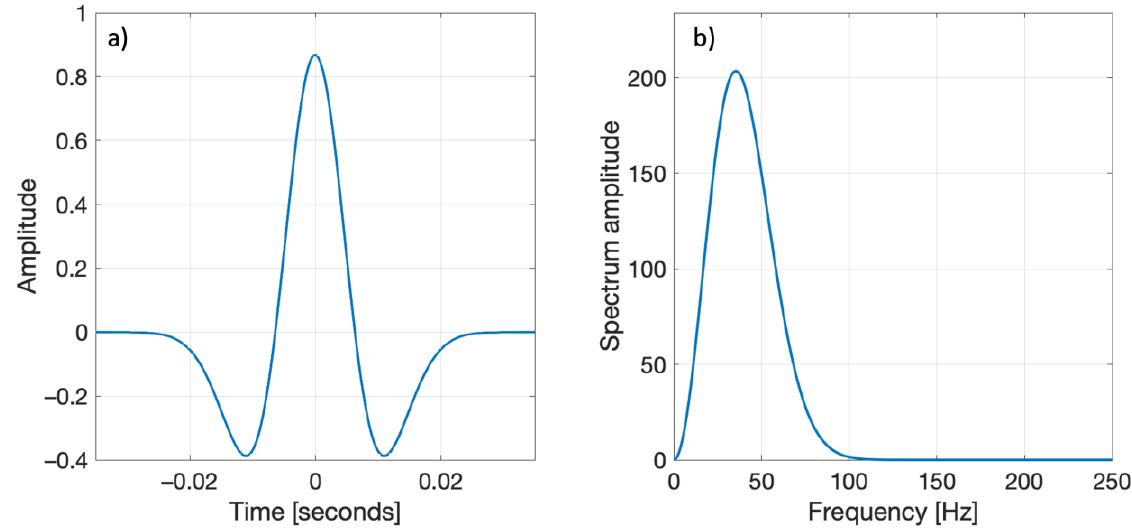
Figure 9. ( a ) The Ricker wavelet used in the modeling of a synthetic source gather and ( b ) its corresponding frequency spectrum. The peak frequency of this wavelet is 35 Hz.